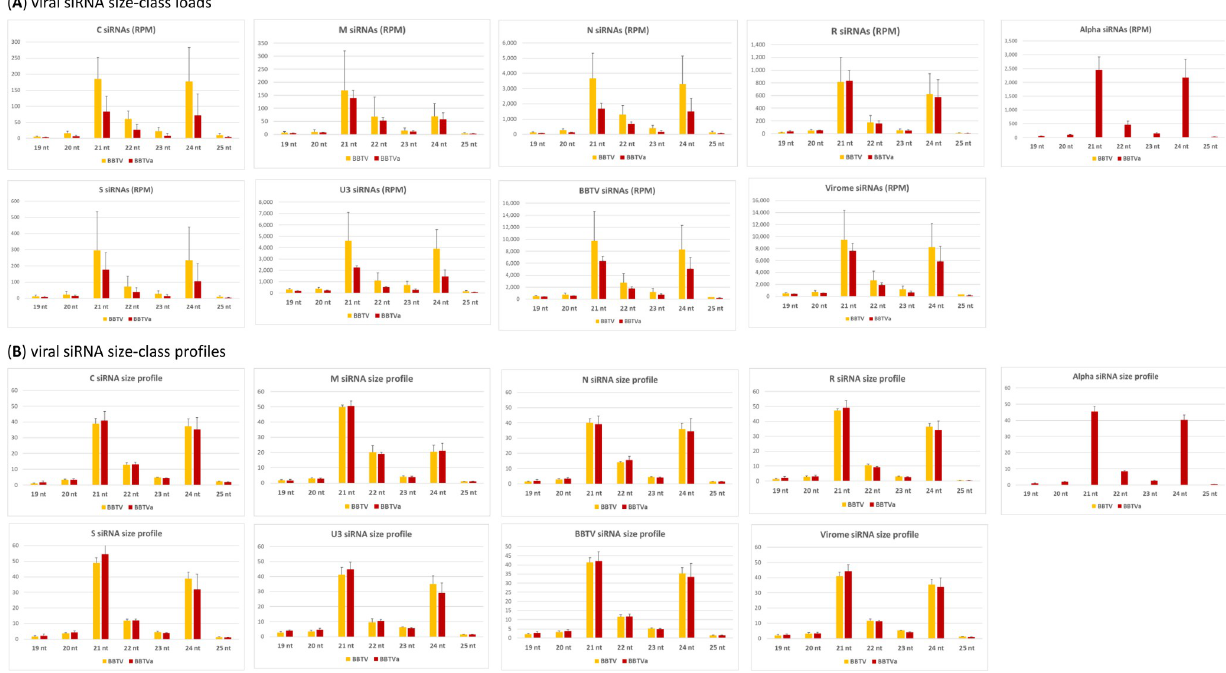
Fig 10. Impact of alphasatellite on accumulation and relative abundance of viral siRNA size-classes. For each of the two conditions, i.e. without (BBTV) and with (BBTVa) alphasatellite, Illumina sRNA-seq 19–25 nt reads of each of the three biological replicates (leaf tissues of three plants) were mapped with zero mismatches onto the reference sequences of complete viral genome components (DNAs C, M, N, R, S, U3, alpha). For each component the loads of each viral sRNA size class were counted in reads per million (RPM) of total plant+viral reads and plotted in panel ( A ), and the relative abundance (formula) of viral sRNA size classes was then calculated in percentage of total and plotted in panel ( B ). Error bars represent standard deviations.